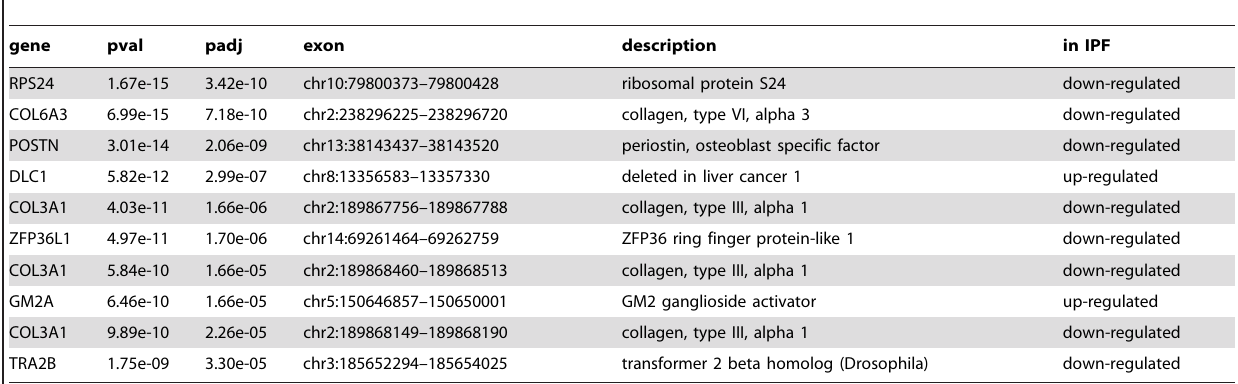
Table 7. Top ten differentially expressed exons (by